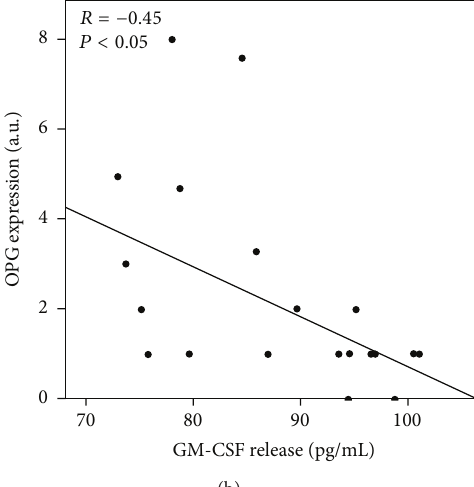
Figure 1: Correlation analyses between spontaneous release of GM-CSF and in vitro biological features of VEC cultures. In (a), positive correlation between baseline release of GM-CSF and in vitro cell proliferation index and between baseline release of GM-CSF expression and TRAIL expression in VEC cultures. In (b), negative correlation between baseline release of GM-CSF and levels of expression of ICAM-1, VCAM-1, and OPG in VEC cultures. Correlation coefficients ( 𝑅 ), calculated by Spearman’s analysis, are reported for each